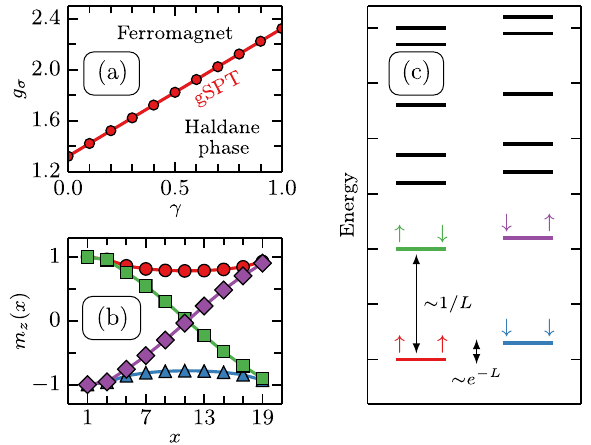
FIG. 4. (a) Phase diagram showing a gSPT line separating the Haldane and ferromagnetic phases obtained from ED on 12 and 16 sites with Δ τ ¼ 10 , g τ ¼ u σ ¼ 0 . 1 , u σ ¼ δ ¼ 0 . 2 . (b) Mag- netization profiles of the lowest four eigenstates via ED on 20 sites with the same parameters as (a), but fixing γ ¼ 0 . 1 , which implies g σ ¼ g c σ ≈ 1 . 421 at the gSPT point. To break the symmetry, a small magnetic field ∼ e − L in the z direction is applied. (c) Cartoon spectrum of H 0 . Colors of states corre- gSPT spond to magnetization